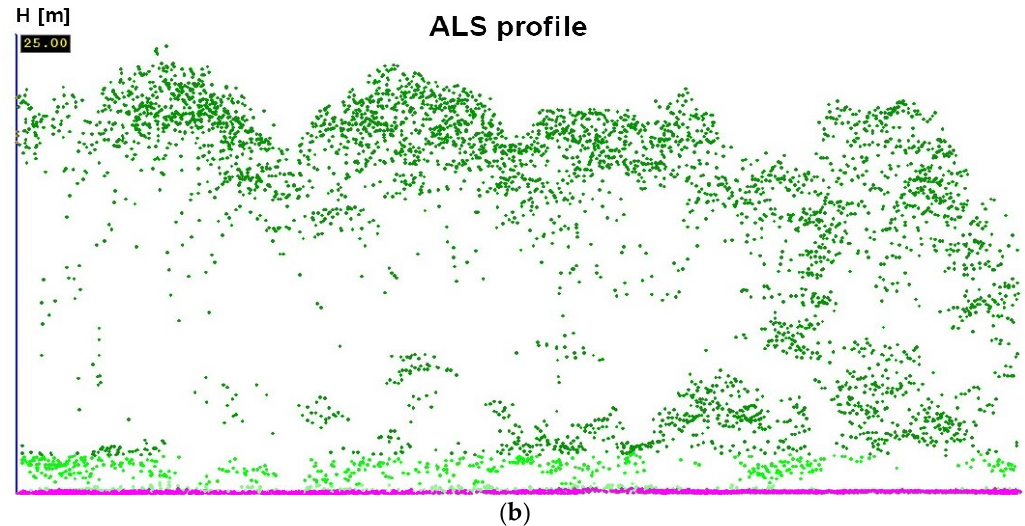
Figure 11. High vegetation: ( a ) histogram; ( b ) profile.